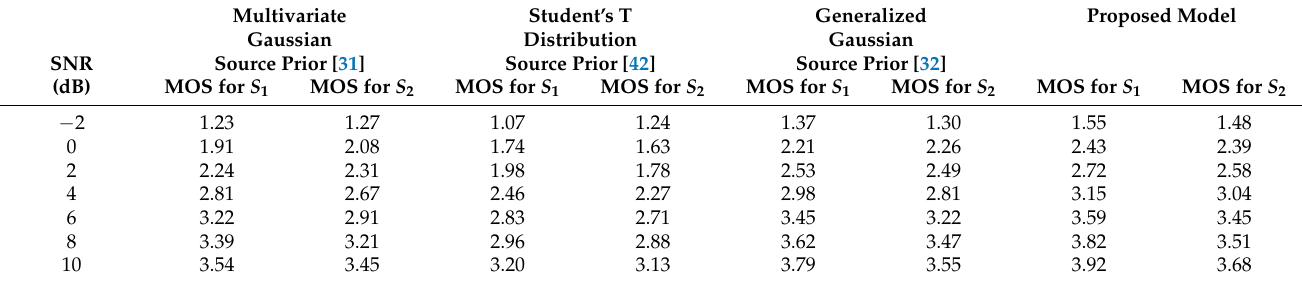
Table 7. Average MOS results of the subjective evaluation for the second model shown in Figure 2 with variable SNR for multistage BSS models having different source priors.